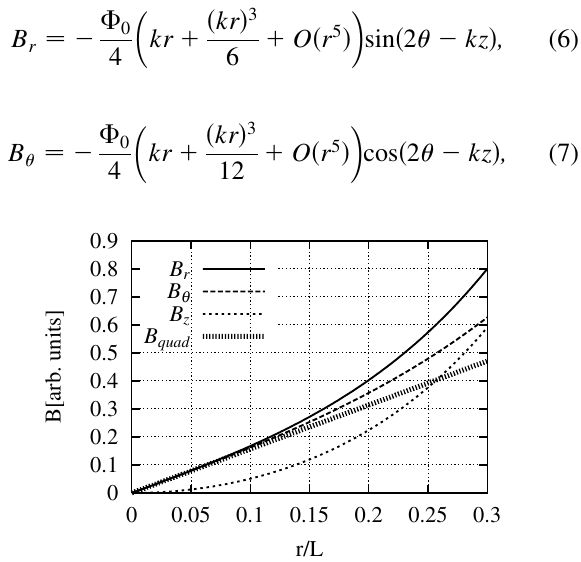
FIG. 1. r dependence of the radial part of both helical and pure quadrupole fields: B